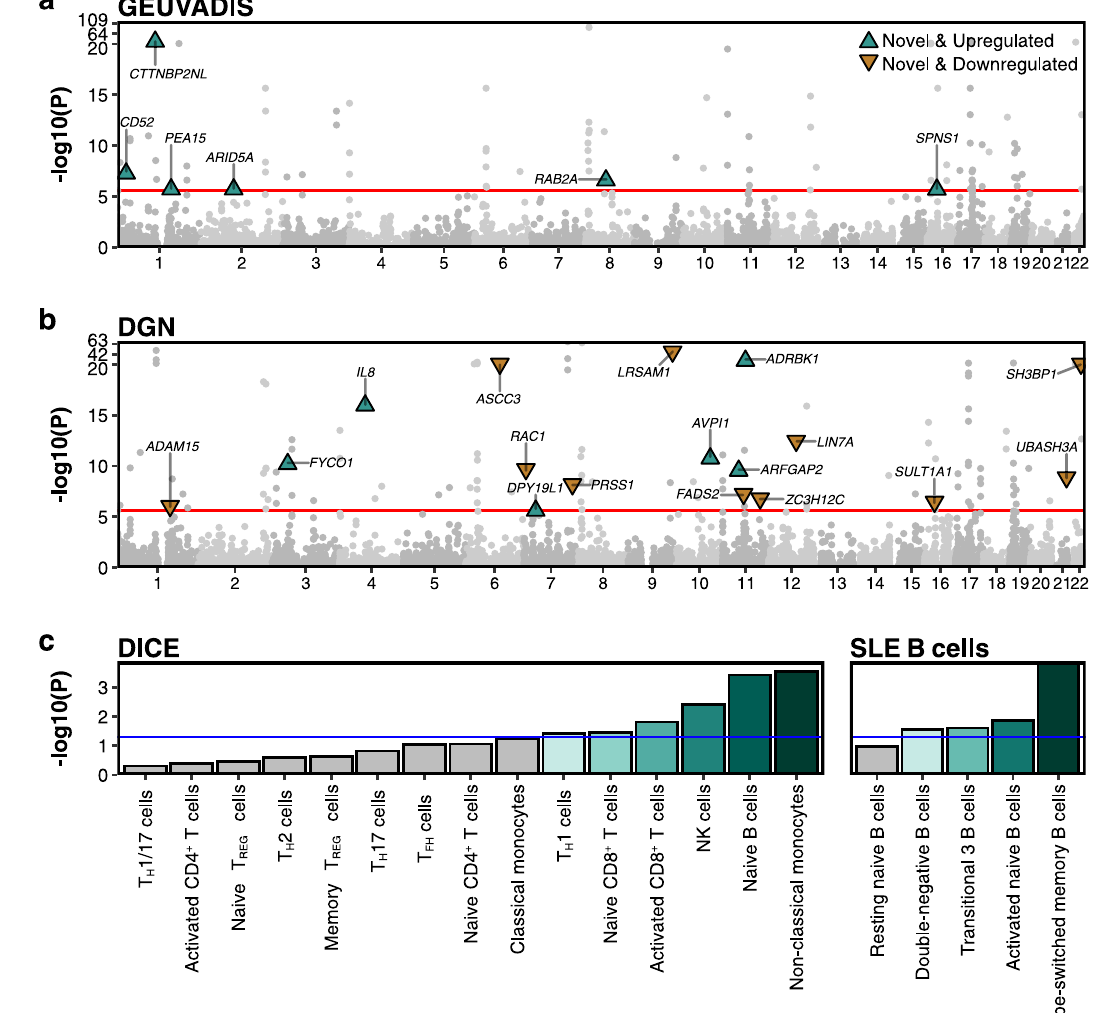
Fig. 3 | Manhattan plot of the transcriptome-wide association studies and subsequent cell type enrichment analyses. Gene expression prediction models are trained in either lymphoblastoid cell line (GEUVADIS dataset, panel a or whole blood (DGN dataset, panel b . The red horizontal line represents the signi fi cance thresholdat2.5×10 − 6